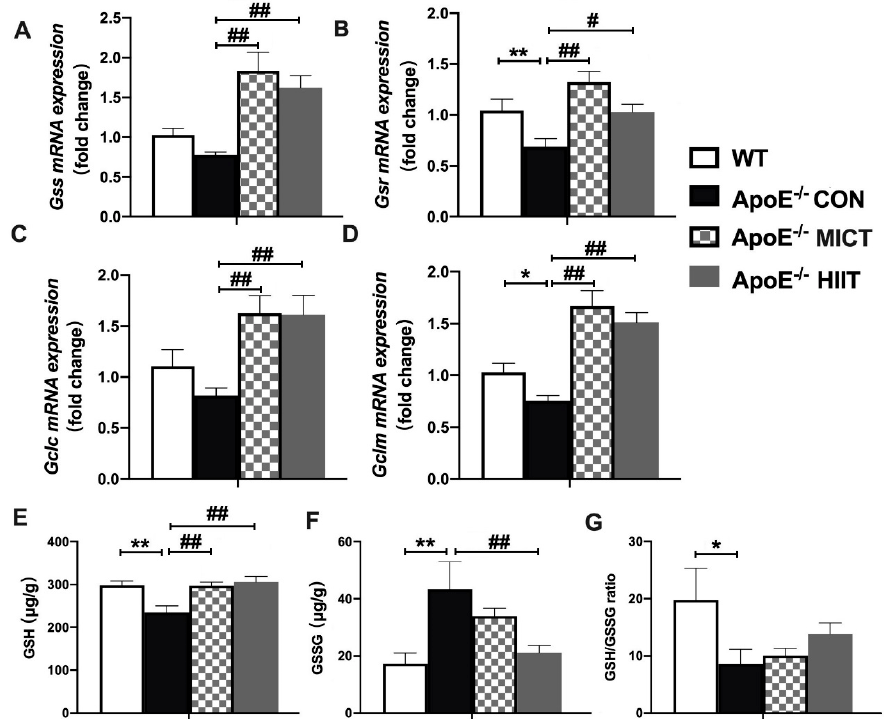
Figure 4. Effects of HIIT and MICT on the mRNA expression of genes involved in the production of GSH ( A – D ), GSH ( E ), GSSG ( F ) levels, and GSH/GSSG ratio ( G ) in skeletal muscles of WT and ApoE KO mice with a high-fat diet. Values are displayed as the mean ± SEM (n = 10/group). * p < 0.05 vs. WT; ** p < 0.01 vs. WT; # p < 0.05 vs. ApoE -/- CON; ## p < 0.01 vs. ApoE -/- CON.